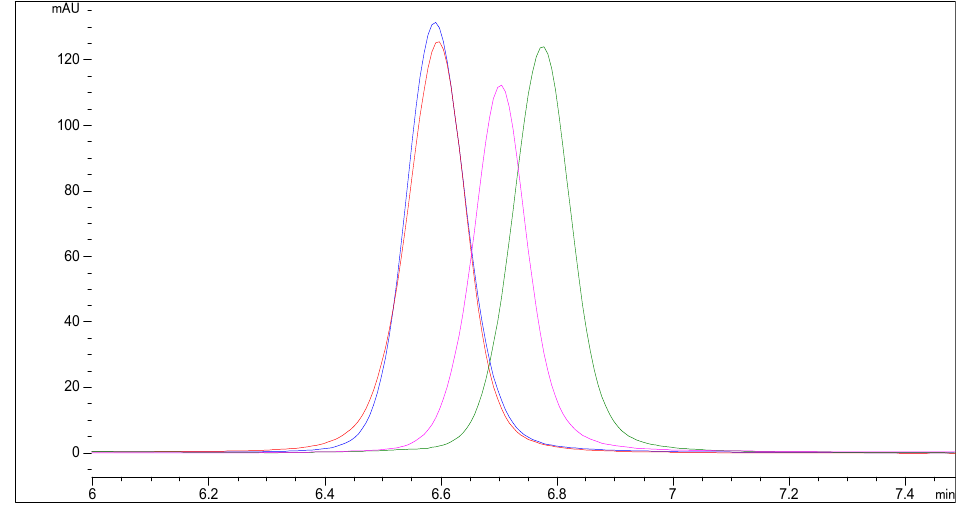
described in Section 2.2.